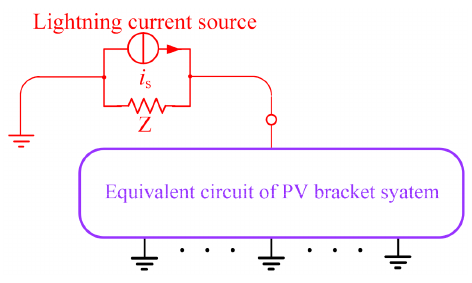
Figure 1. Photovoltaic (PV) bracket system.